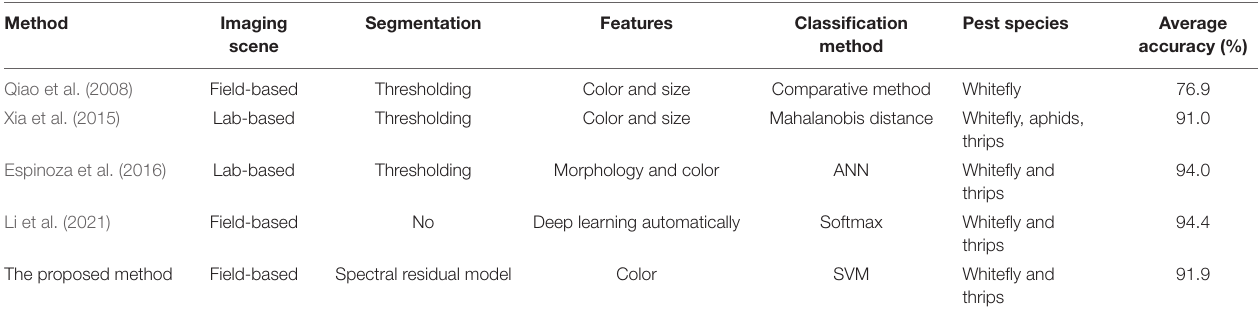
Pest species Average method accuracy